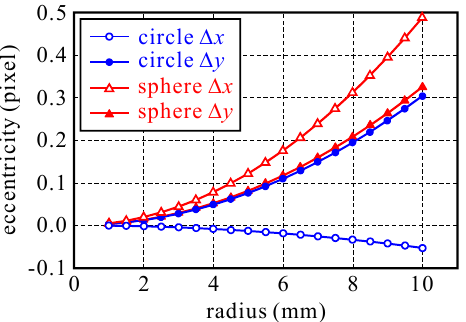
Figure 6. Eccentricity vs. radius at P6 where   =